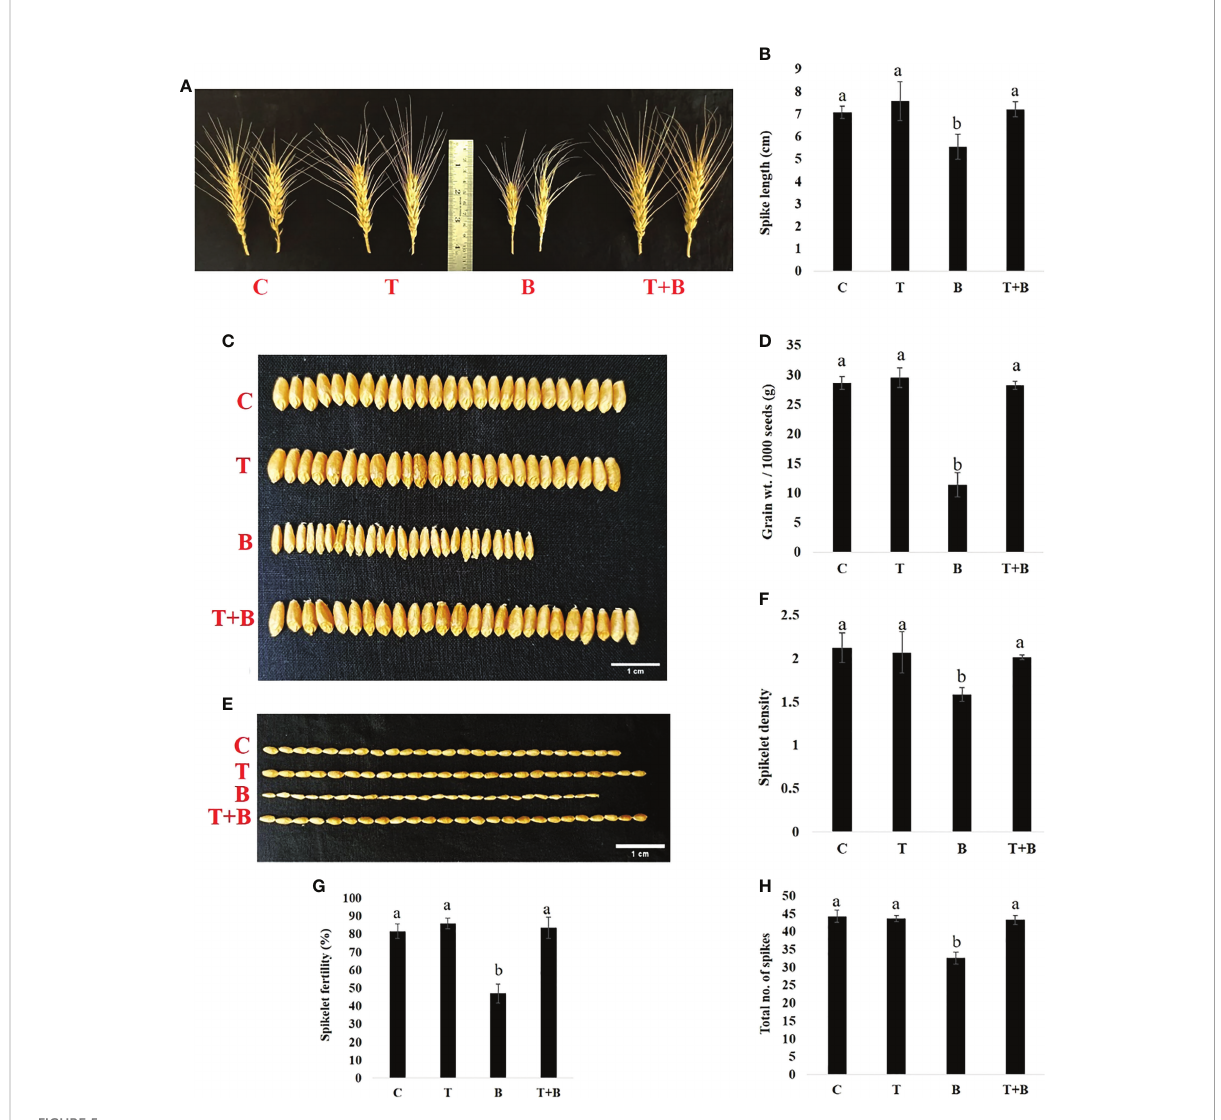
FIGURE 5 Effect of Trichoderma -priming on the yield of the wheat in G0 after challenging with Bipolaris sorokiniana HD 3069. (A, B) Spike length, n =21 (C) Grain width. Scale bar = 1 cm, n = 25, (D) Grain weight / 1000 seeds (n=1000) (E) Grain length. Scale bar =1 cm, n = 25, (F) Spikelet density; (G) Spikelet fertility; and (H) Total no. of spikes of wheat after challenging with Bipolaris . C = control, T = Trichoderma -primed, B = Non-primed wheat challenged with Bipolaris , T+B = Trichoderma -primed and challenged with Bipolaris . Data in (B, D, F – H) are represented as mean ± SD and different alphabets indicate statistically signi fi cant difference at P<0.05 in Tukey's test. Results are representatives of three independent biological replicates. (n =